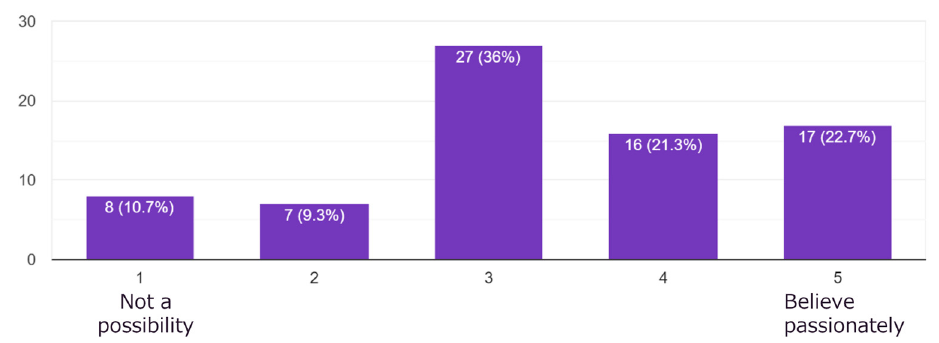
Figure 12. Response to community survey regarding willingness to donate energy during disaster relief.